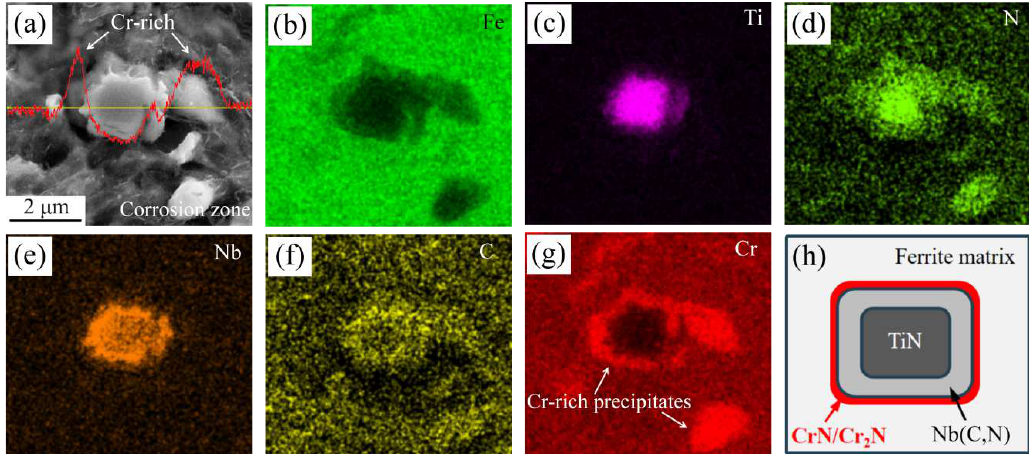
Figure 6. Morphology, structure, and element distribution of inclusion in intergranular corrosion zone in steel-3: ( a ) TiN- Nb(C,N) composite inclusion after HTUC and line scanning by using EDS to show the Cr distribution, ( b – g ) area scanning of the inclusion by using EDS, and ( h ) schematic diagram of composite inclusion.